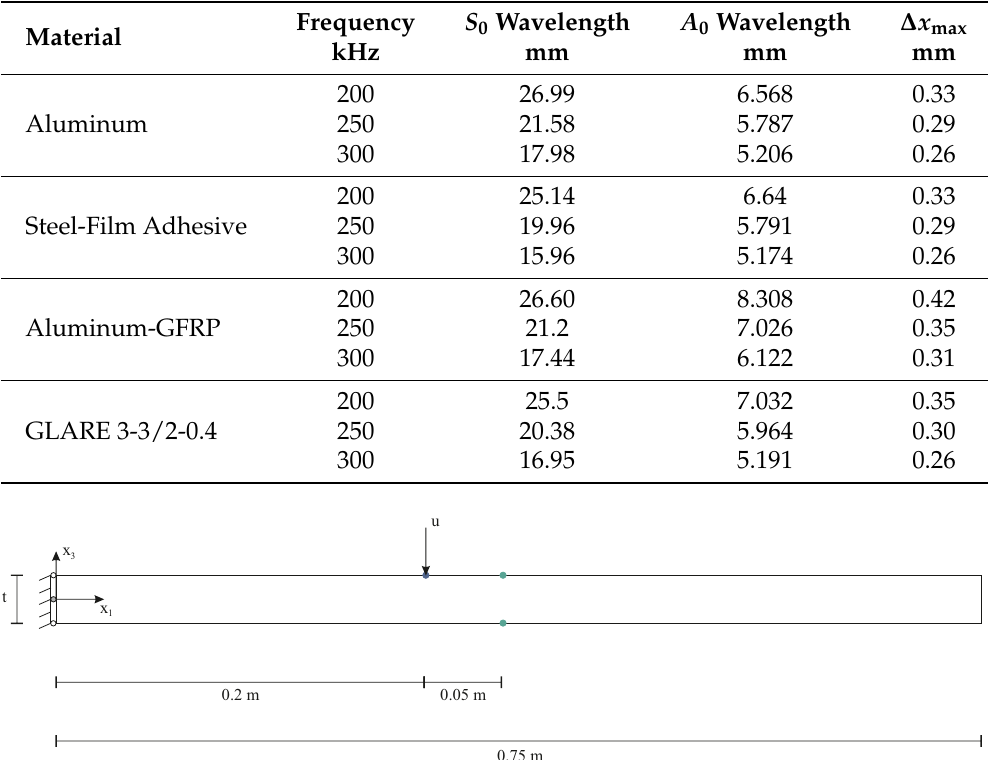
Table 3. Overview of wavelengths for the excited wave modes.